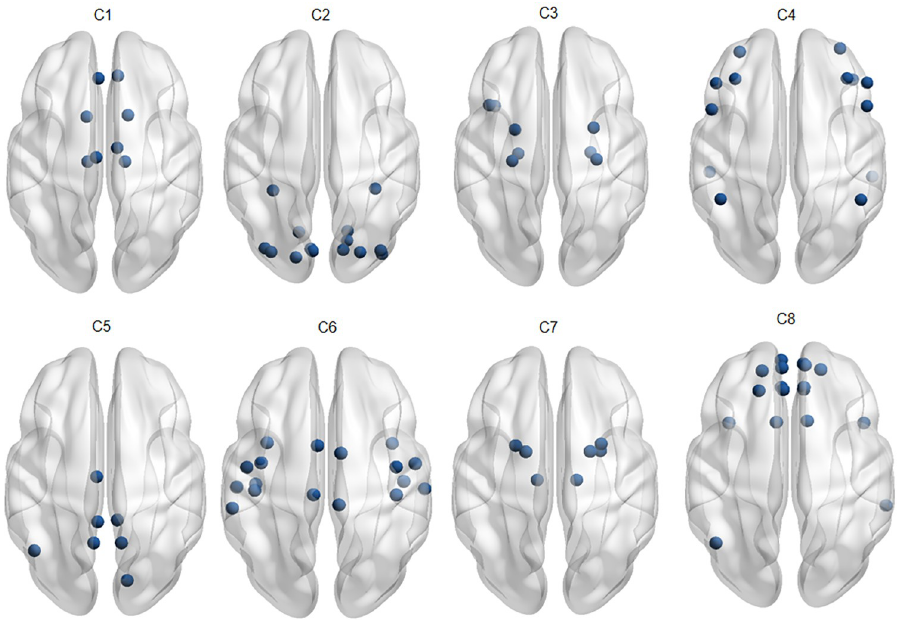
Fig 3. Overlapping communities derived from LR-MVRC. This figure displays the communities derived from the LR-MVRC based adjacency matrix via thresholding of matrix P obtained with NMF ( K = 8). Eight communities derived from LR-MVRC matrix shown in this figure refer to default mode and subcortical (C1), visual (C2), bilateral limbic (C3), cognitive control and default mode (C4), default mode and visual (C5), auditory and motor (C6), subcortical (C7), and default mode and bilateral limbic (C8) networks.